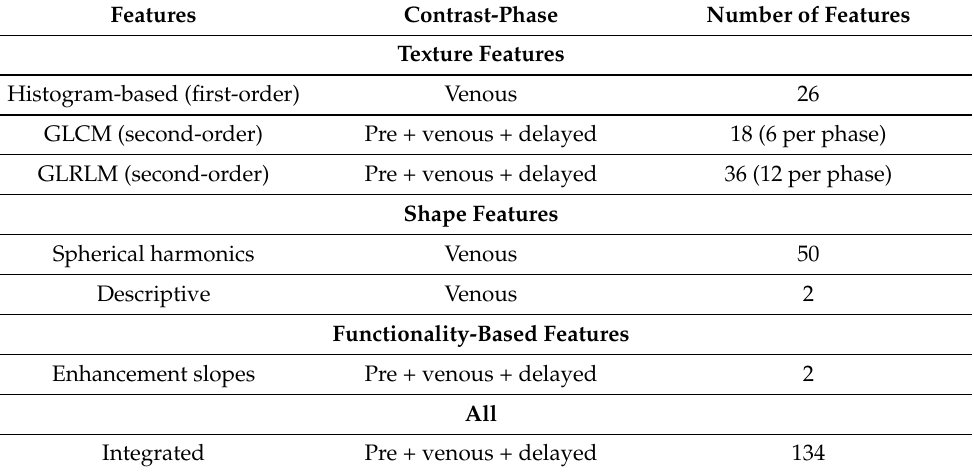
Table 1. The number of entries for each group of extracted features and the phase they are ex- tracted